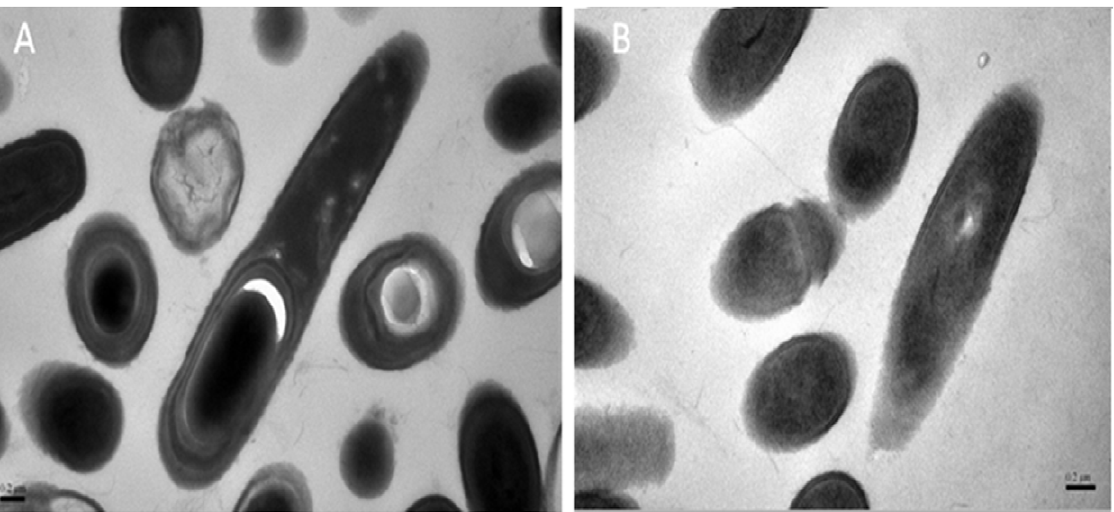
Figure 7. Transmission electron photomicrographs (at 50000 6 magnification) of B.subtilis treated with RAcc-royalisin. (A) Untreated B. subtilis . (B) B. subtilis treated with RAcc-royalisin at 37 u C for 48 hours. Bar represents 0.2 m m.